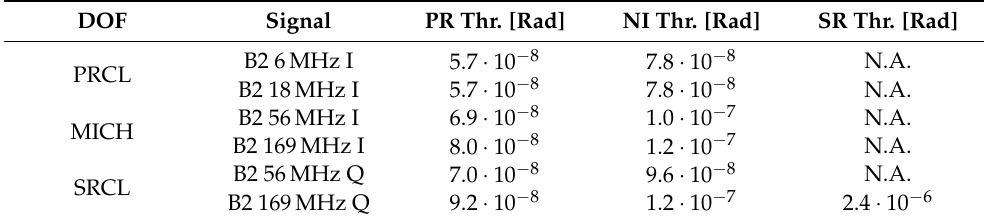
Table 2. 50% OG loss thresholds for each error signal. Each column shows the respective mirror misalignment at which the error signal loses 50% of its optical gain. For SR misalignments (last column), most of the error signals do not reach the 50% threshold in the simulated range (up to 3.0 · 10 − 6